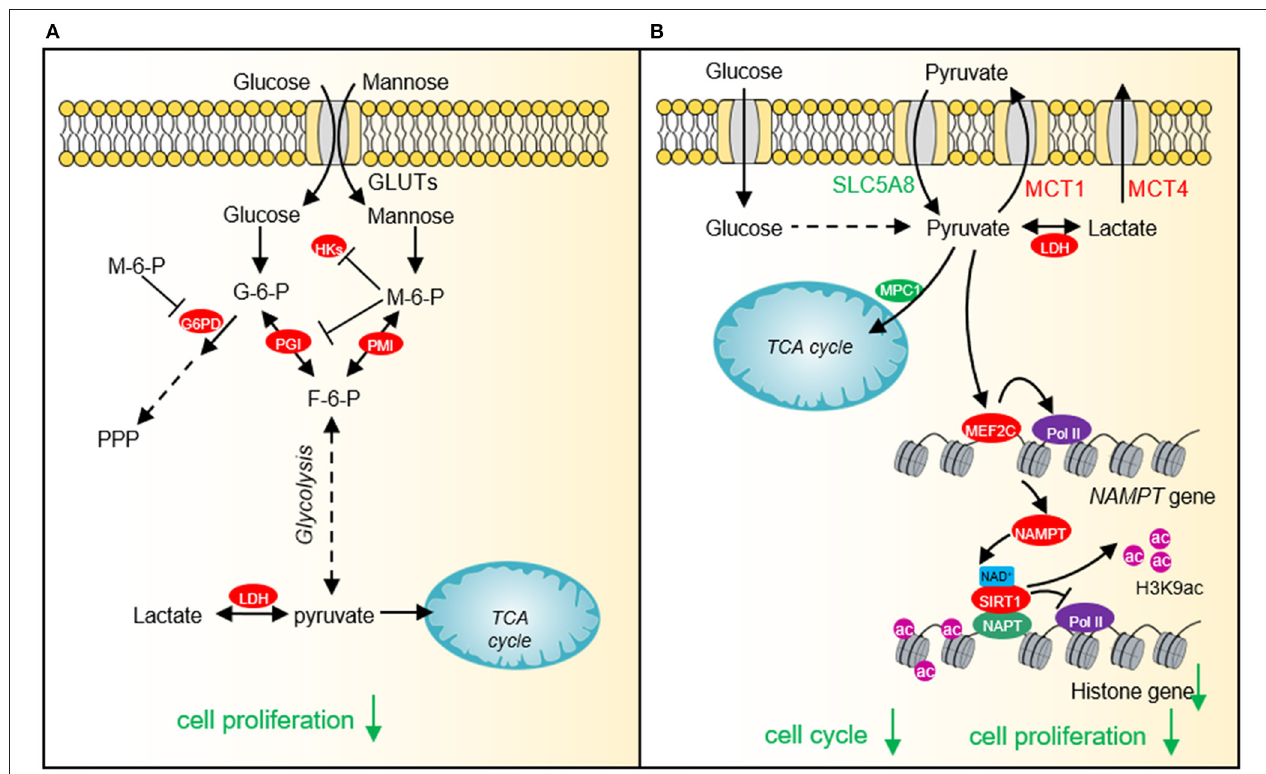
FIGURE 3 | The effect of mannose and pyruvate on cancer cell proliferation. (A) Exogenous mannose generates mannose-6-phosphate under the catalysis of hexokinase. High levels of mannose-6-phosphate significantly inhibit aerobic glycolysis and pentose phosphate pathway (PPP) by inhibiting the activities of hexokinase, PGI and G6PD, which affects lactate production and TCA cycle, resulting in cell growth arrest and chemotherapeutic sensitivity. (B) Pyruvate represses histone gene expression by inducing the expression of NAD + biosynthesis enzyme, nicotinamide phosphoribosyltransferase (NAMPT) via myocyte enhancer factor 2C (MEF2C), which then increases NAD + levels and activates the histone deacetylase activity of SIRT1. Downregulated histone gene expression leads to cell cycle arrest and tumor cell growth defects. HKs, hexokinases; G-6-P, glucose-6-phosphate; M-6-P, Mannose-6-phosphate; PMI, Mannose-6-phosphate isomerase; PGI, phosphoglucose isomerase; F-6-P, fructose-6-phosphate; LDH, lactate dehydrogenase; SLC5A8, Sodium-coupled monocarboxylate transporter 1; MCT1, Monocarboxylate transporter 1; MCT4, Monocarboxylate transporter 4; MEF2C, myocyte enhancer factor 2C; NAMPT, nicotinamide phosphoribosyltransferase; SIRT1, Silent mating type information regulation 2 homolog-1; NPAT, Nuclear protein of the ataxia telangiectasia mutated